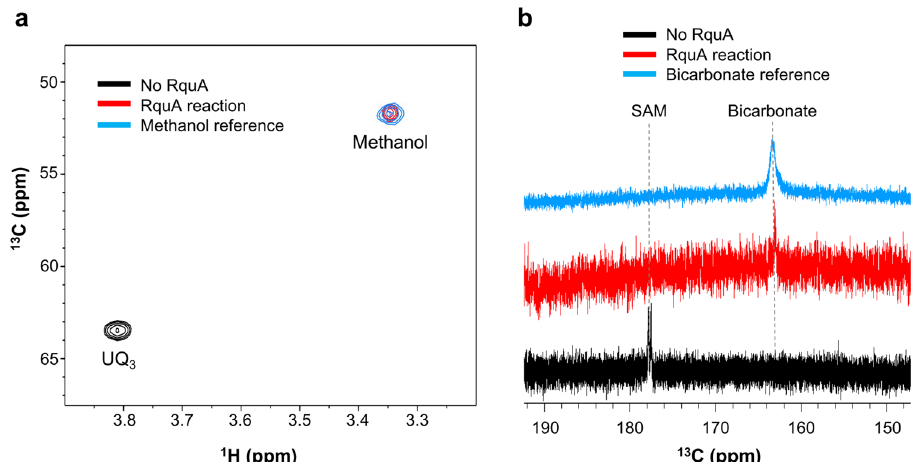
Fig. 5 Identi fi cation of RquA reaction products by NMR. a 13 C-methanol is a product generated by RquA from ubiquinone-3 (UQ 3 ). Assays were performed using puri fi ed S -adenosyl- L -methionine (SAM, 400 µ M), 5- 13 C-methoxy-UQ 3 (200 µ M), and RquA (25 µ M) in assay buffer. 1 H- 13 C spectra are overlaid for a control sample lacking RquA (black), the complete reaction (red), and for a sample of 0.1% methanol in assay buffer (blue). b Bicarbonate is detected in the RquA in vitro reaction. Assays were performed using puri fi ed 13 C 5 15 N-SAM (200 µ M), UQ 3 (350 µ M), and RquA (25 µ M) in assay buffer. Stacked 1 H-decoupled 13 C spectra are shown for a control sample lacking RquA (black), for the complete reaction (red), and for a sample of sodium bicarbonate (50 mM) in assay buffer